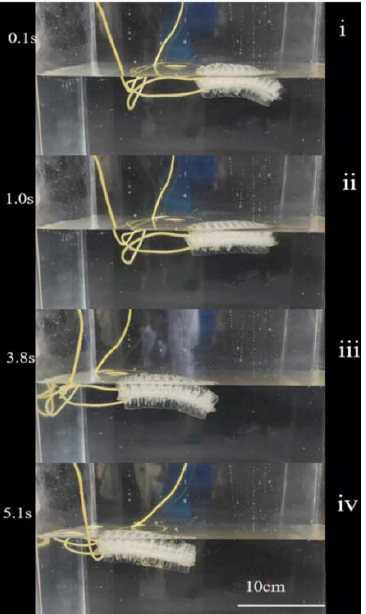
Figure 3. ( a ) The bending effect of the actuator at different angles in experiments and simulations. ( b ) Simulated effects of the actuator bending bidirectionally. ( c ) The bending angles of the actuator under different pressures in experiments and simulations.